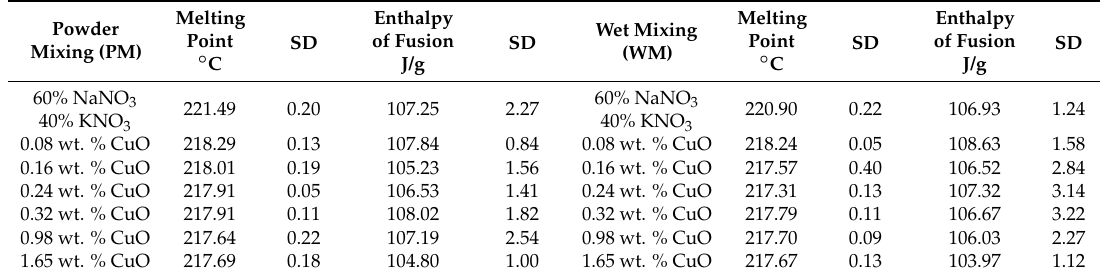
Table 3. Melting and enthalpy of the different tested ratios of salt + nanoparticles.